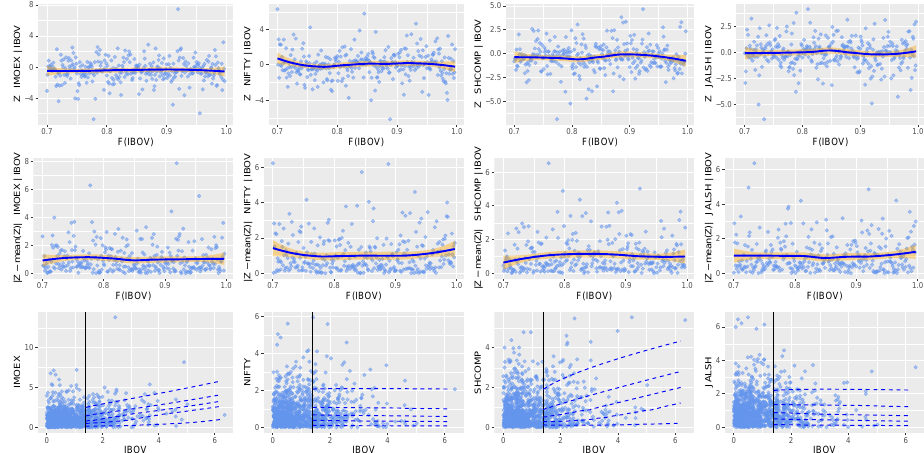
Figure A2. Dependence model diagnostics: conditioning on the IBOV